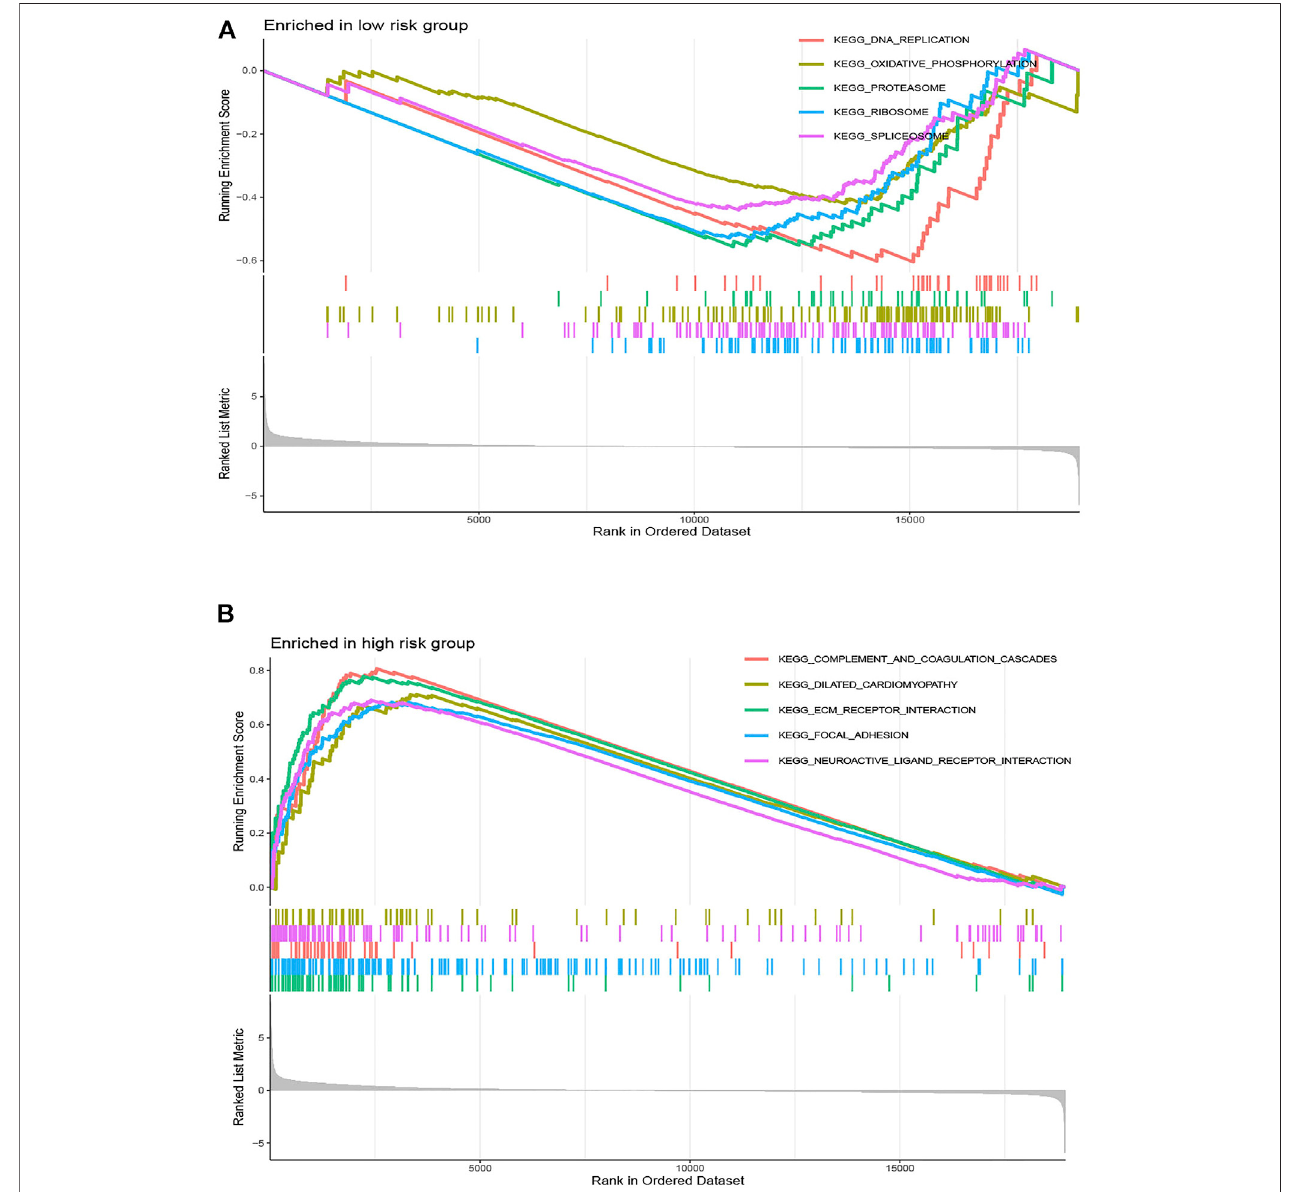
FIGURE6| Geneset enrichmentanalysiscorrelatedwiththerisk score.Gene set enrichmentanalysisofthe top fi ve pathways signi fi cantlyenriched in (A) thelow- risk group and (B) the high-risk group.